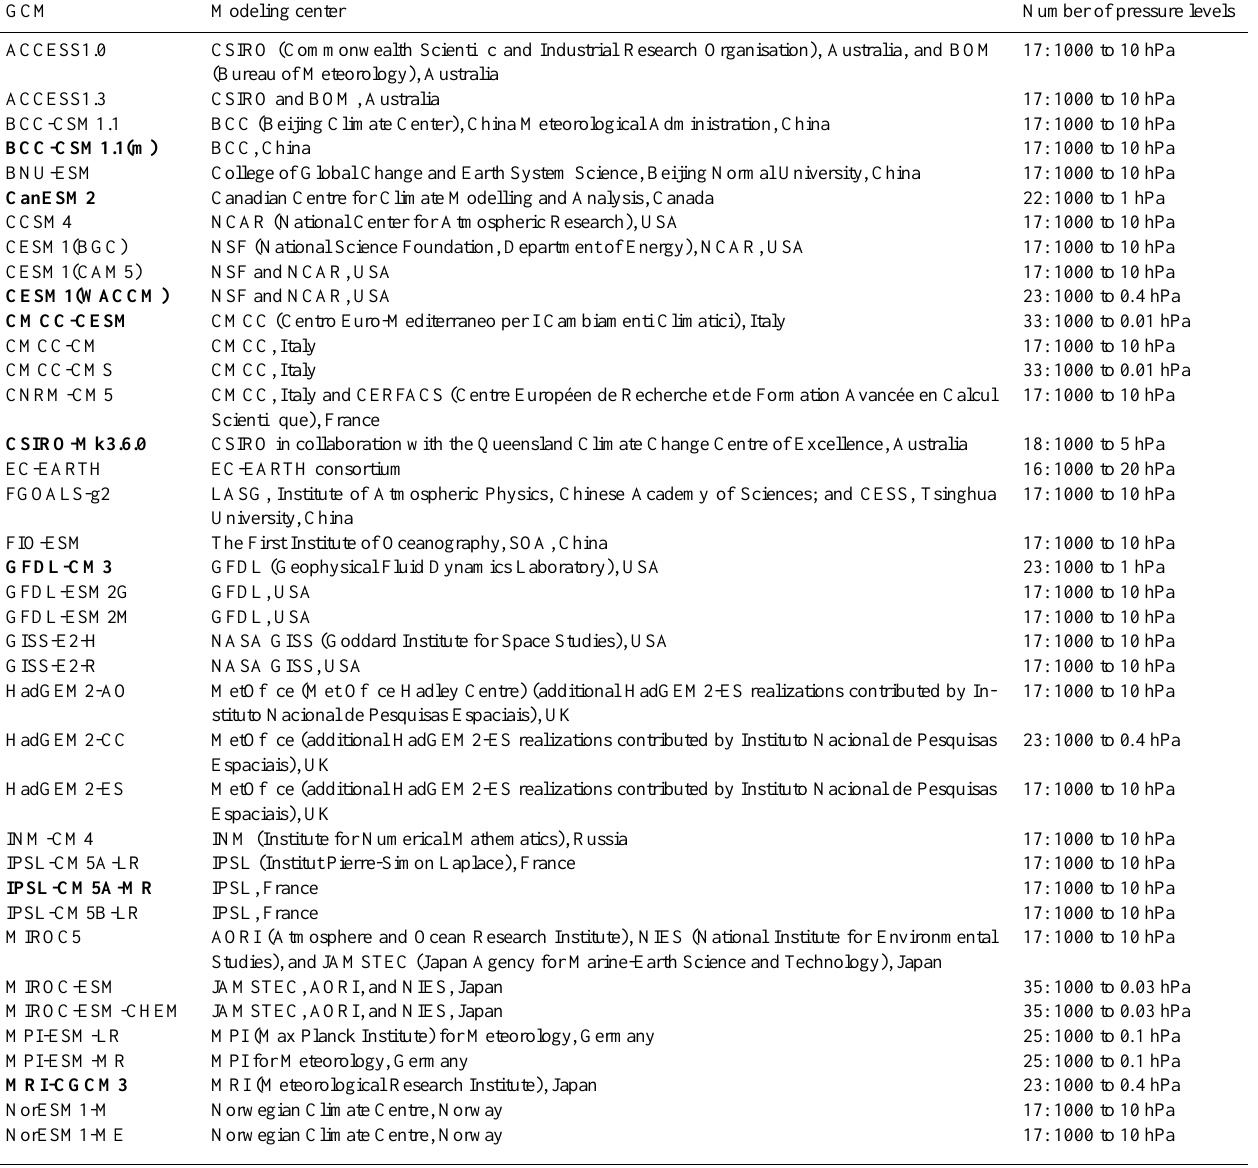
Table 1. List of all GCMs with emission scenario RCP8.5 from the CMIP5 database in alphabetical order. The bold font highlight the reduced set of CMIP5 models (“max